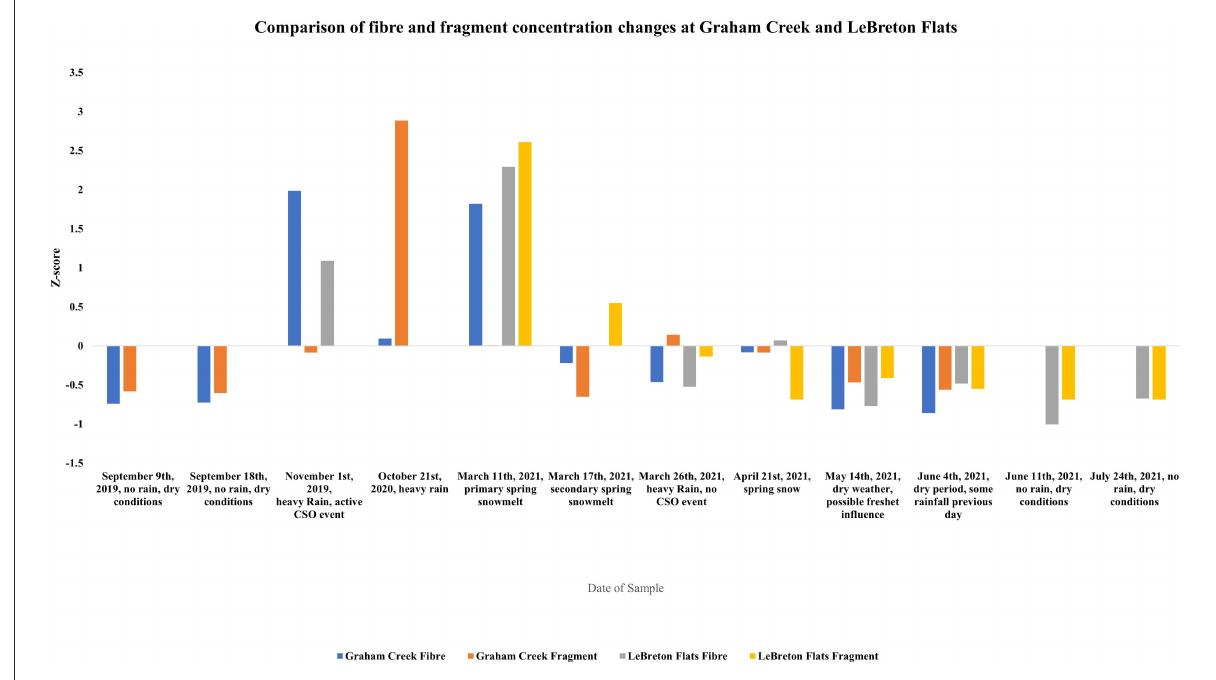
FIGURE4 Z-score values for comparison of the change in fibers and fragments between Graham Creek and LeBreton Flats during various temporal events.